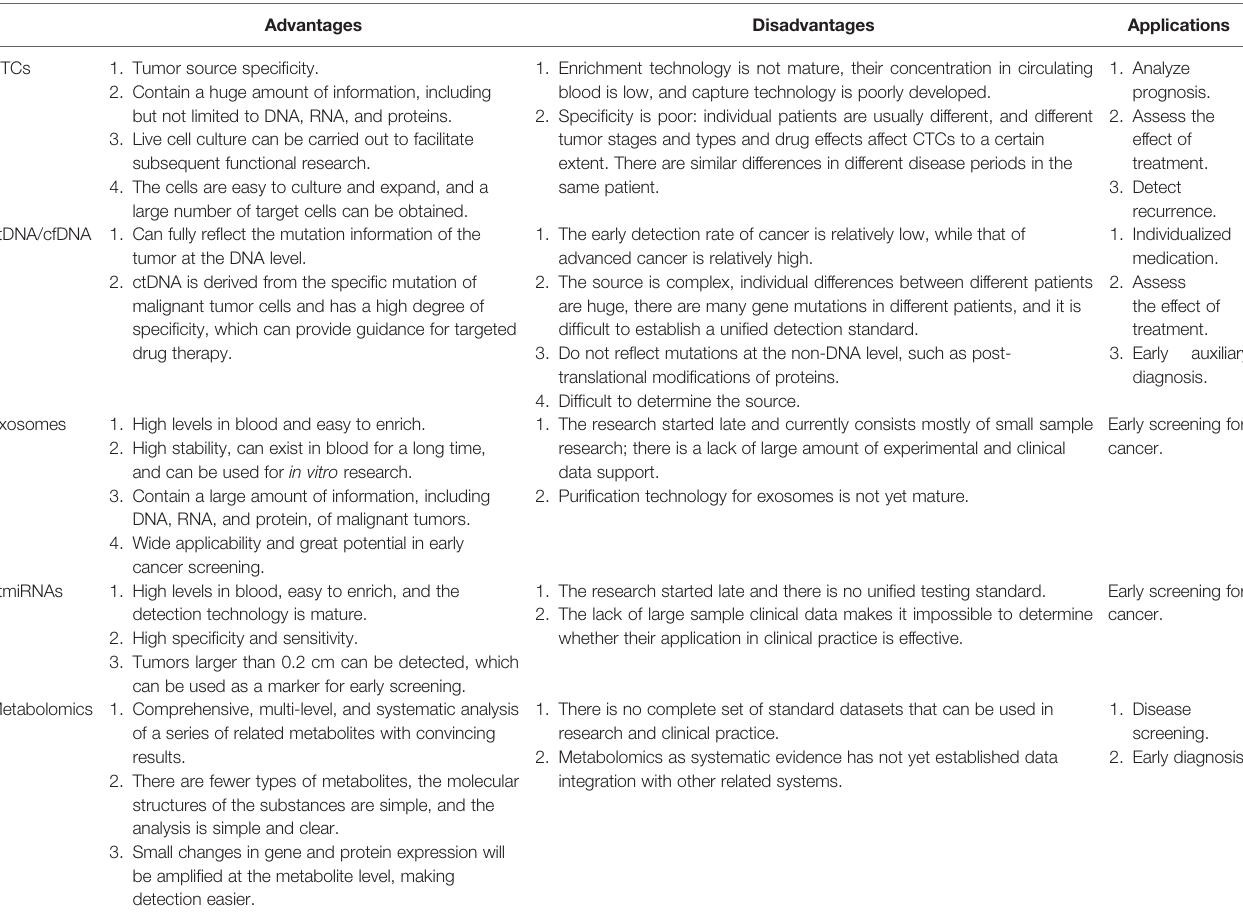
TABLE 1 | Comparison of advantages and disadvantages of liquid biopsy